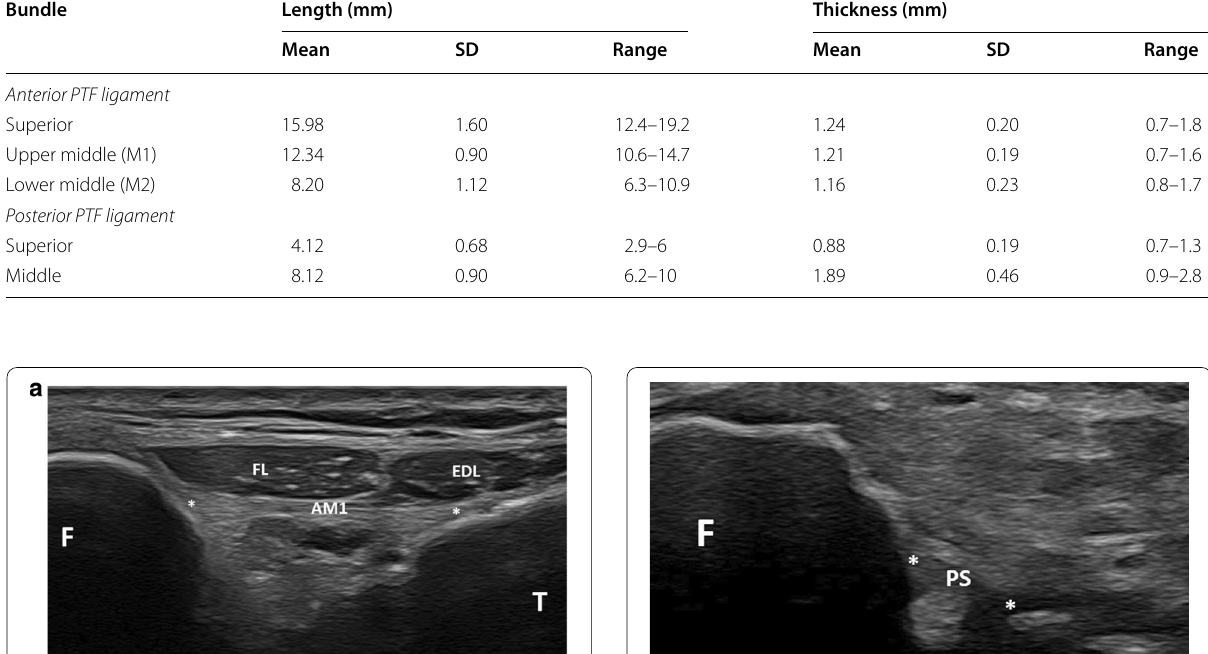
Table 1 Length and thickness of the PTF ligaments. PTF proximal tibiofibular, SD standard deviation, mm millimetre Bundle